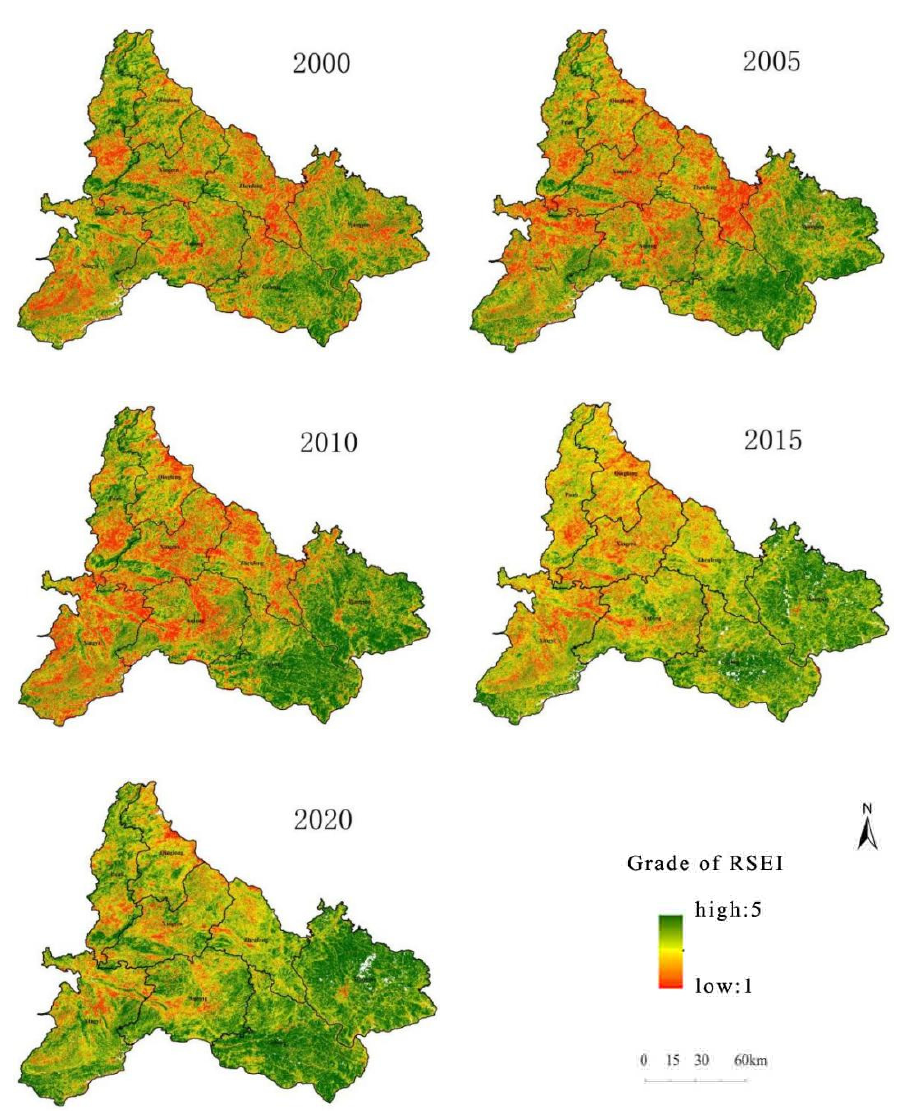
Figure A1. Distribution of RSEI from 2000 to 2020.